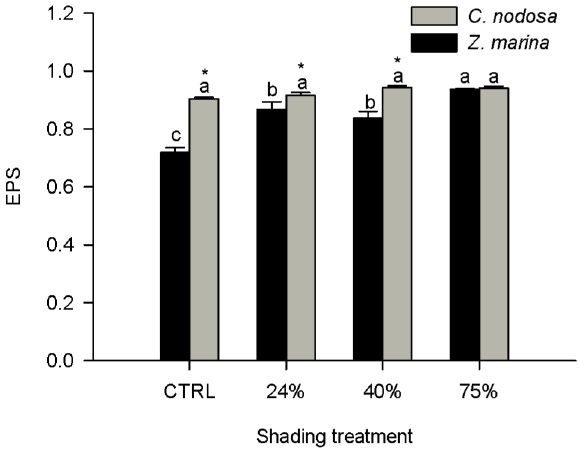
Figure 4. Epoxidation state of xanthophyll cycle pigments [EPS = (V + 0.5A)/(V + A + Z)] in Zosteramarina and Cymodoceanodosa . Plants submitted to shading treatments of 24, 40 and 75% of naturally available photosynthetically active radiation (CTRL). Different letters indicate significant differences between treatments, * indicates differences between species (n=5, p , 0.05).